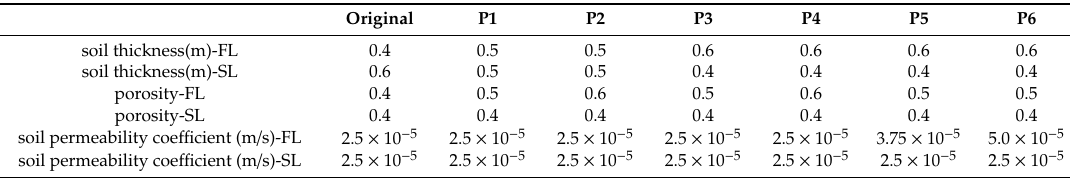
Table 2. Simulation scenario settings.